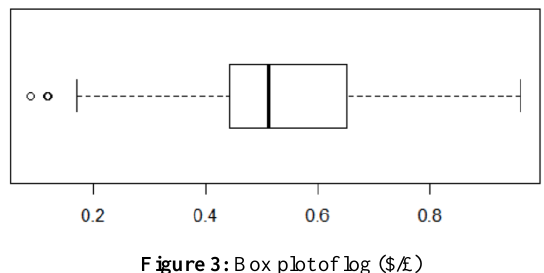
Figure 3: Box plot of log ($/£)